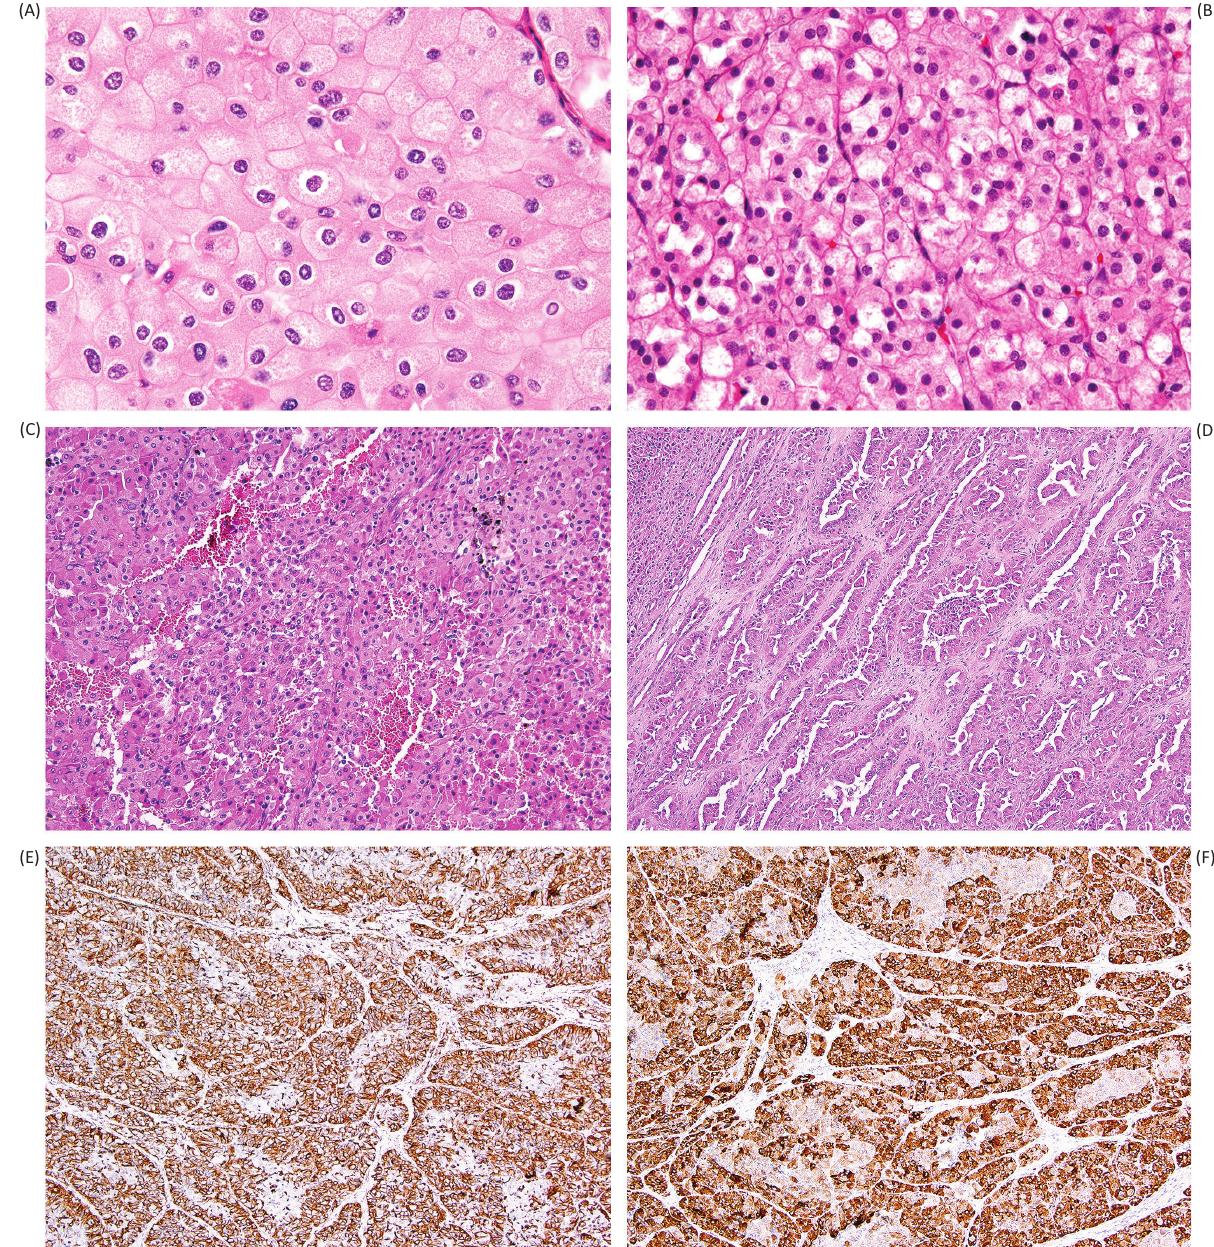
Figure 4. Mimics of oncocytoma include eosinophilic variant chromophobe renal cell carcinoma (A), in which distinction from oncocytoma is challenging, but is favored by perinuclear clearing (“halo”), nuclear wrinkling and irregularity, and substantial trabecular growth pattern. Succinate dehydrogenase-deficient renal cell carcinoma (B) is a more recently recognized entity that may closely mimic oncocytoma due to bland, uniform cytology; however, clues to this diagnosis include diffuse growth pattern (rather than tubular or nested formation) and cytoplasmic inclusions of flocculent material (sometimes referred to as vacuoles), likely representing large abnormal mitochondria. Papillary renal cell carcinoma with oncocytic features (C) can also mimic oncocytoma; however, this diagnosis should be suspected in the presence of substantive papillary formation (D) or positivity for vimentin (E). Labeling for alpha-methyl-acyl-coA racemase (AMACR) is typically very strong and diffuse in all patterns of papillary renal cell carcinoma